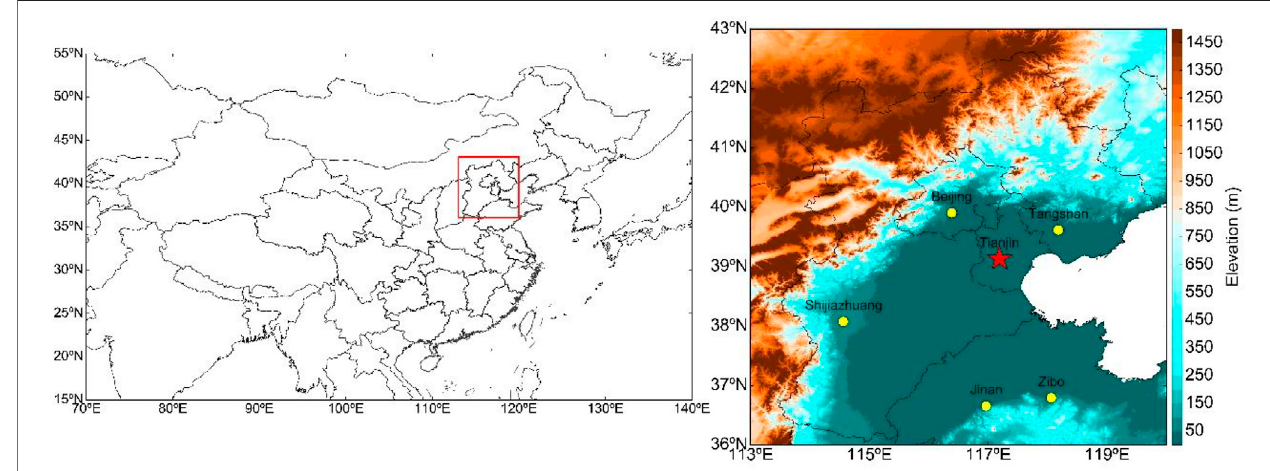
FIGURE 1 | Study site and its surrounding area in the NCP; the red star represents Tianjin.